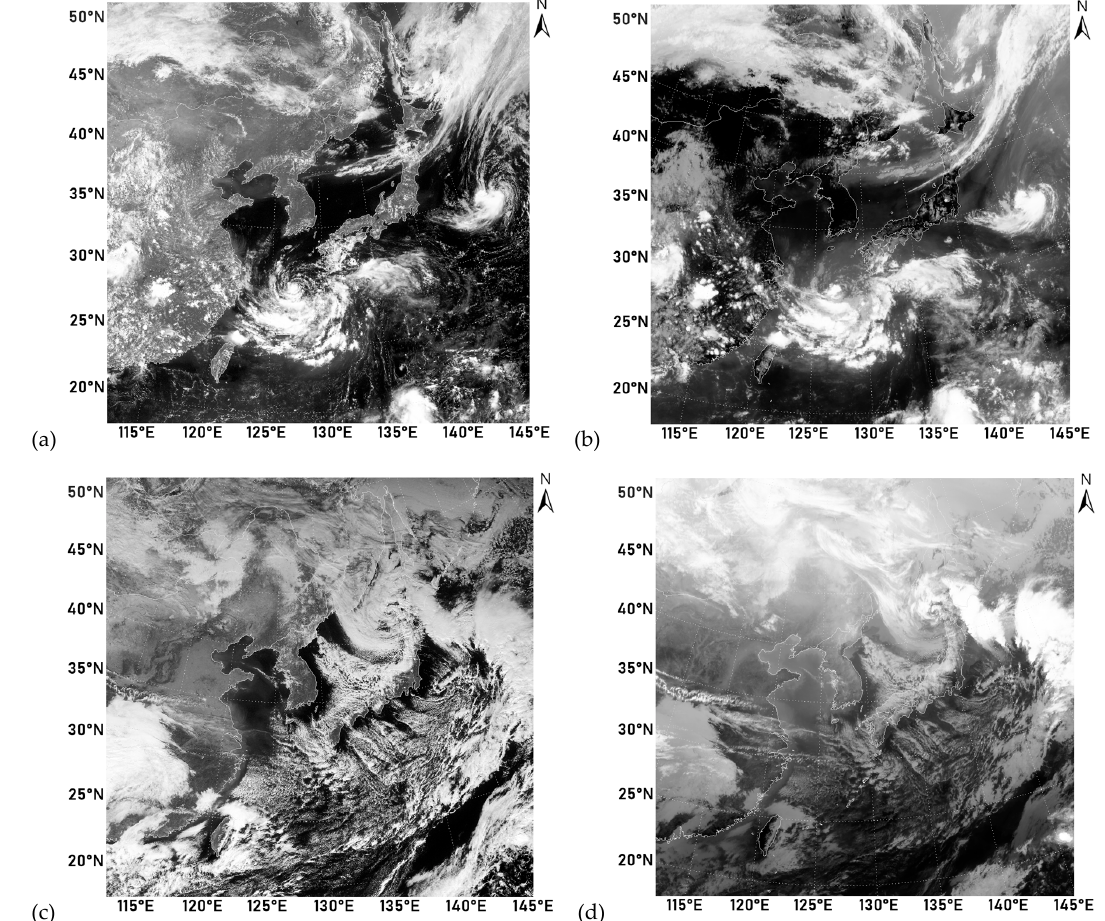
Figure 1. Examples of Communication, Ocean, and Meteorological Satellite (COMS) Meteorological Imager (MI) observations. ( a ) Reflectance in the visible (VIS) band and ( b ) radiance in the infrared 1 (IR1) band on August 1, 2018 (summer). ( c ) Reflectance in the VIS band and ( d ) radiance in the IR1 band on January 1, 2018 (winter). Time is 04:00 UTC (13:00 KST, daytime) for all the images.